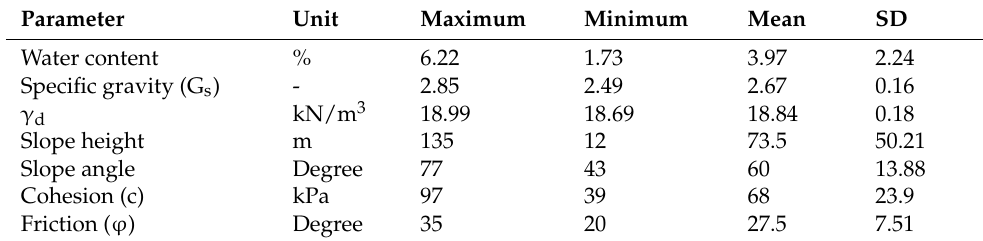
Table 1. Geotechnical characteristics of the studied